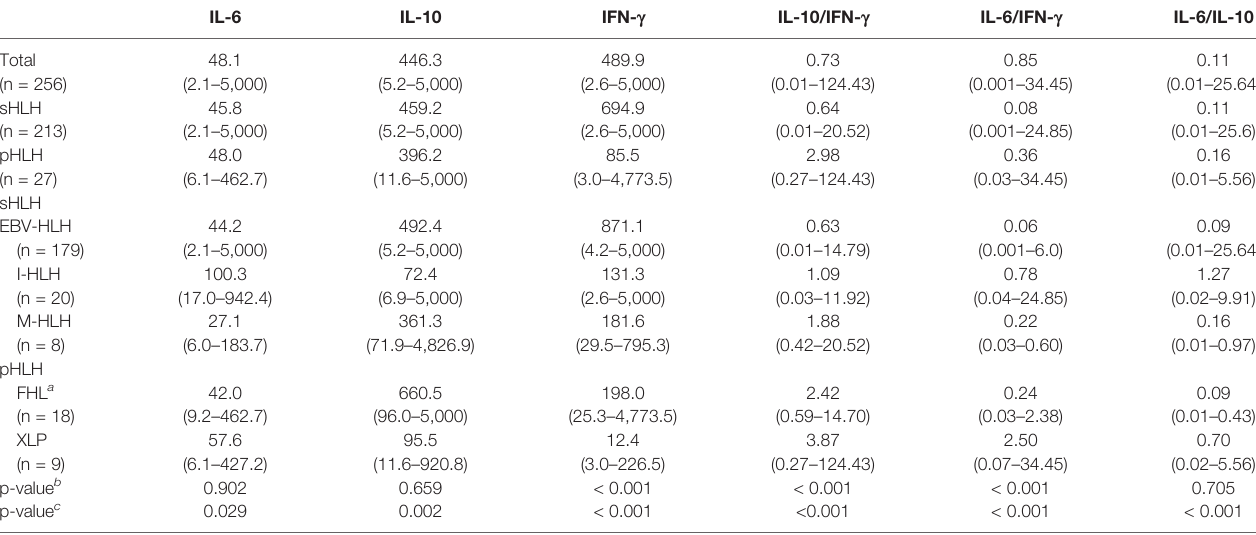
TABLE 2 | Cytokine levels and ratios in different forms of HLH.